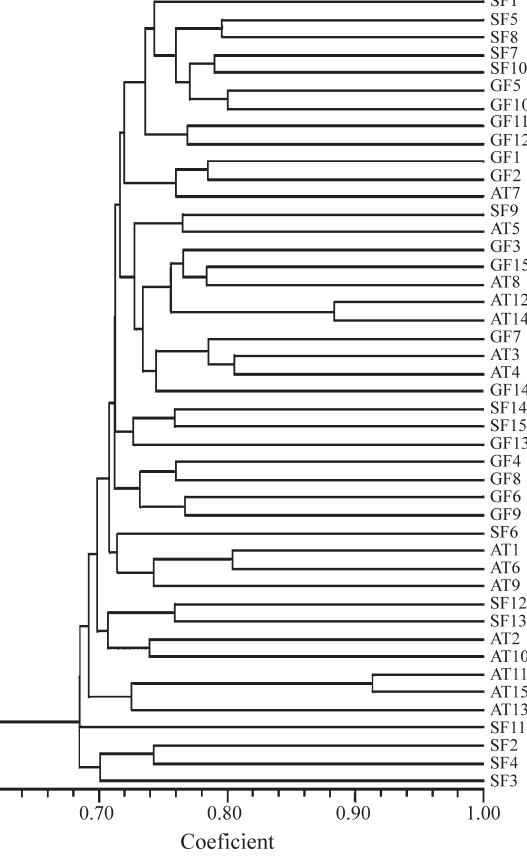
Figure 3 - Dendrogram constructed using the Jaccard coefficient and the unweighted pair group method with averages (UPGMA) method for Eufriesea violacea males from three forest remnants in northern Paraná, Brazil. SF = São Francisco State Park, GF = Godoy Forest, AT = Arthur - Thomas